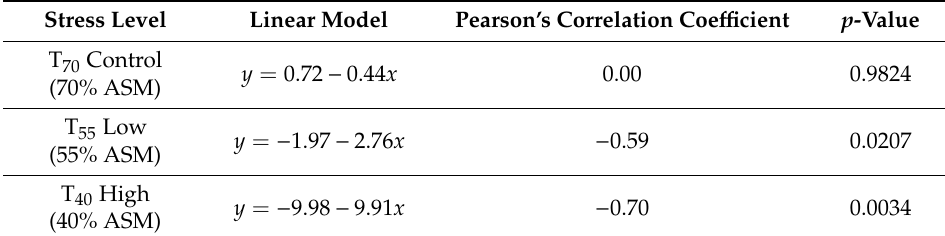
Table 4. Regression analysis between stomatal resistance and leaf water potential under di ff erent stress levels.